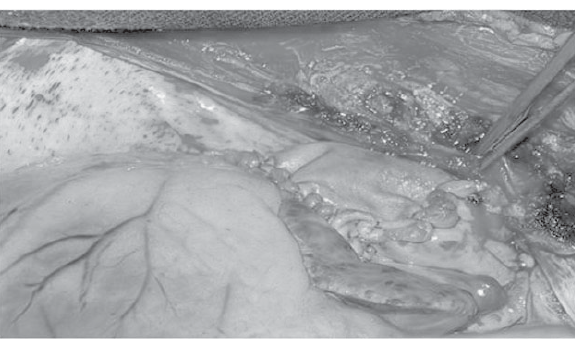
Fig. 3 - Reconstrução parcial do átrio direito com pericárdio